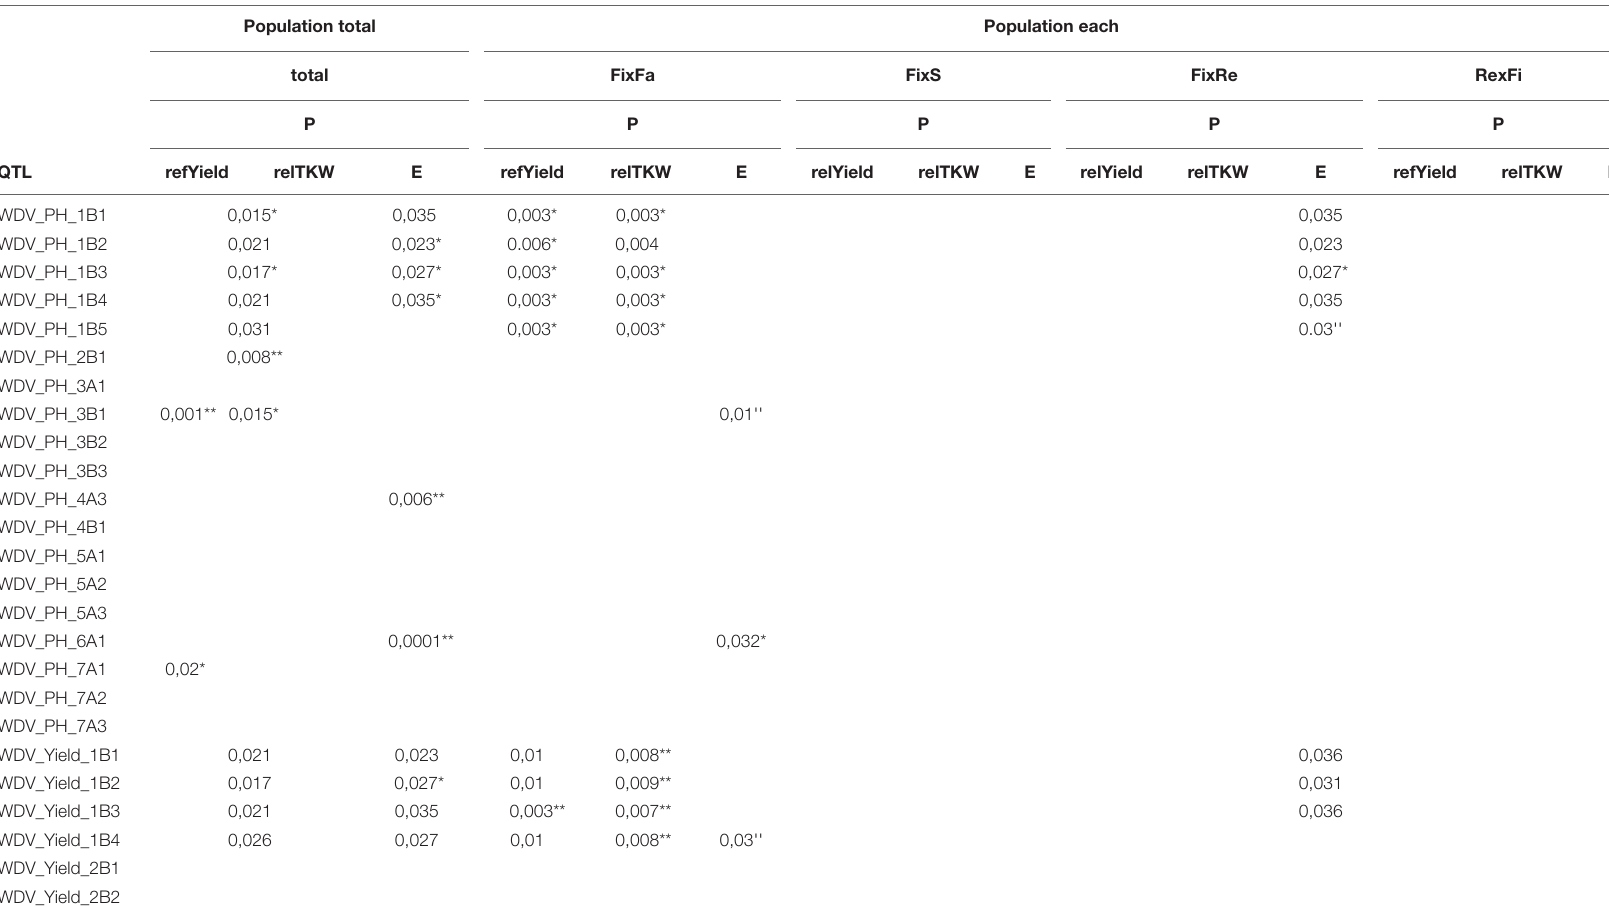
TABLE 4 | Validations of the identified QTL using a t -Test, *, ** indicate significant differences between allele means at 5% and 1% level,